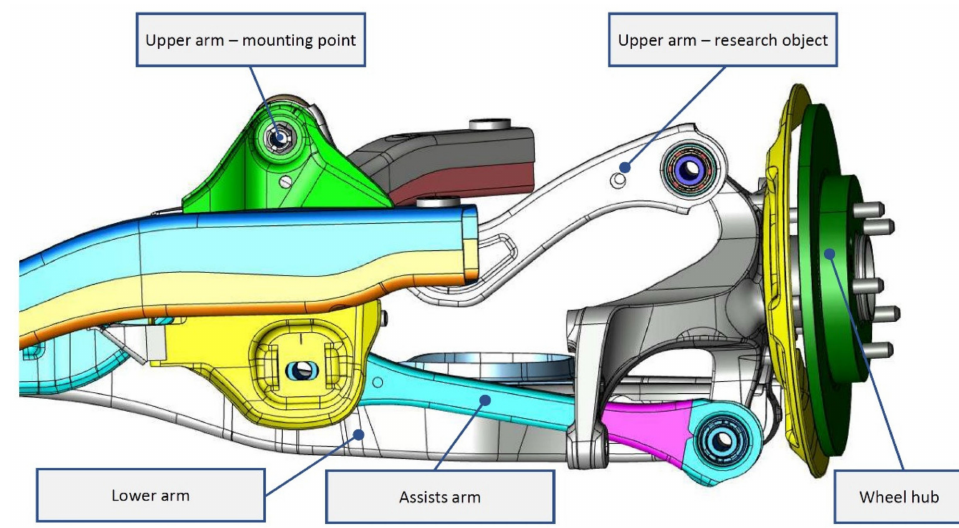
Figure 2. Alignment